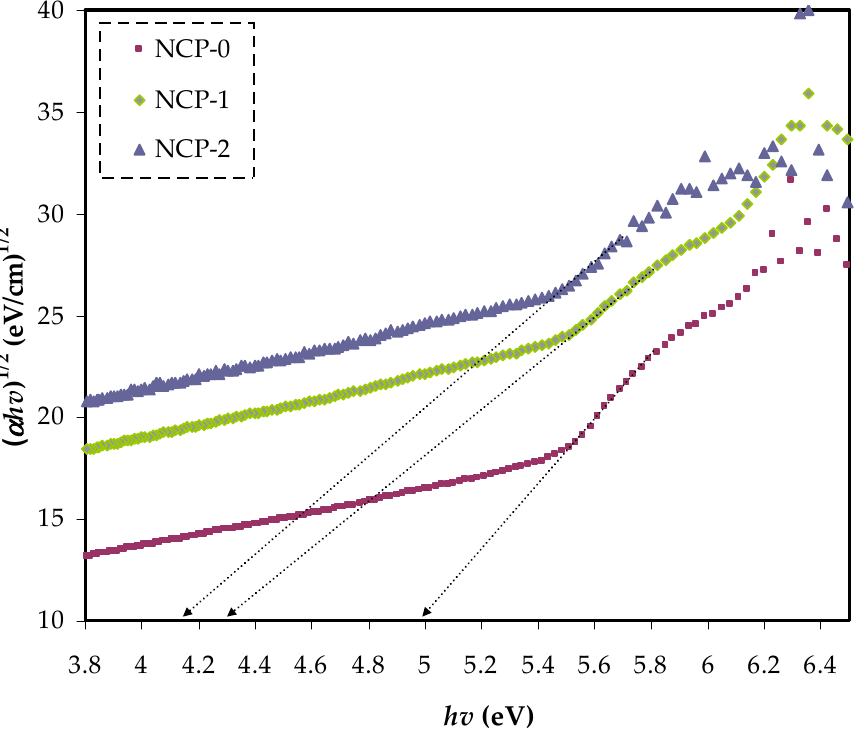
Figure 10. ( α h υ ) 1/2 v photon energy for NCP-0 and composite samples.